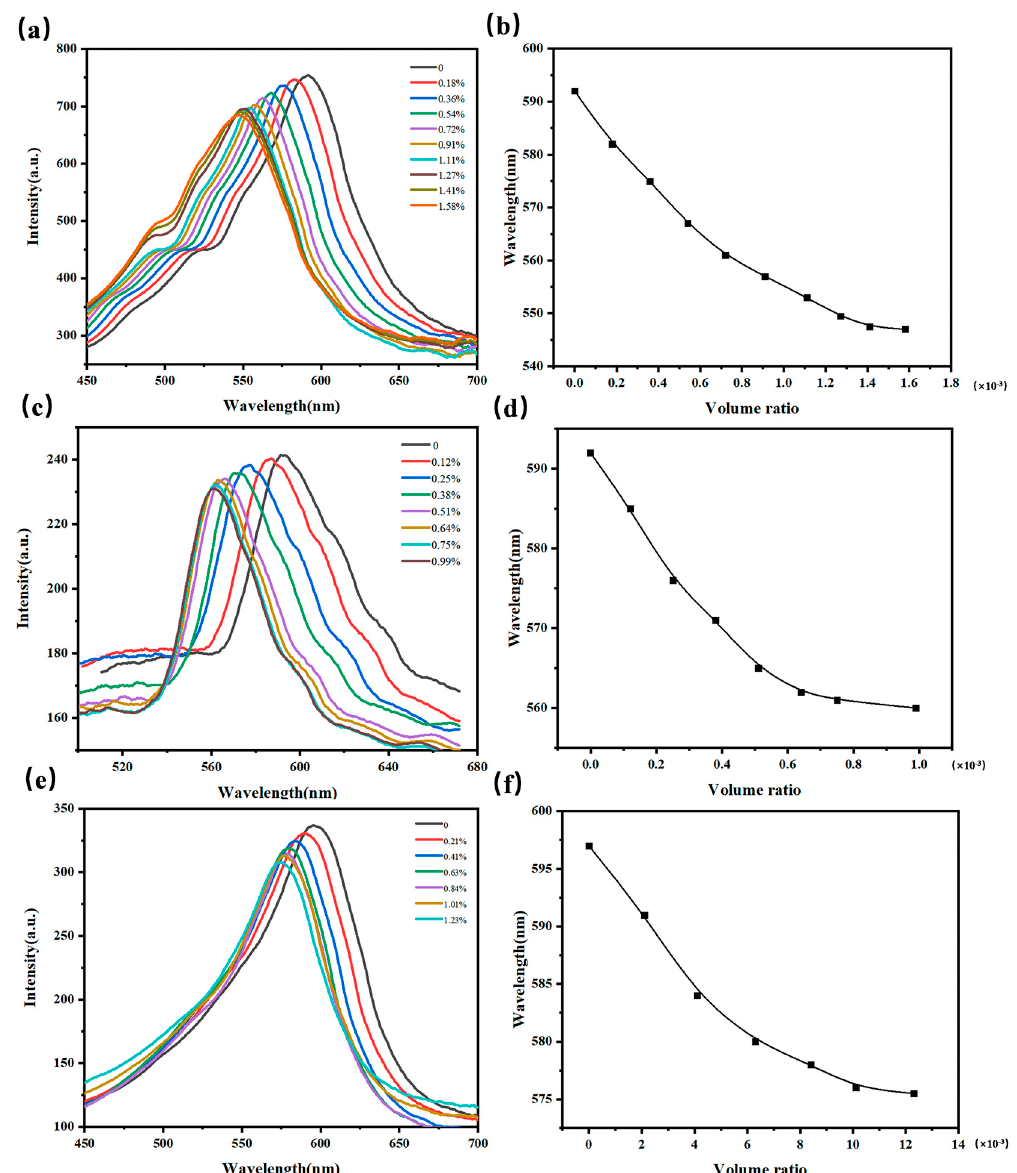
Figure 6. Responses of the 3D I − (A −β− CD) − AM PCs to VOC gas. ( a ) λ max responses of 3D I − (A −β− CD) − AM PCs to methanol gas; ( b ) the relationship between the wavelength of λ max and volume ratio; ( c , d ) λ max responses of 3D I − (A −β− CD) − AM PCs to ethanol gas; ( e , f ) λ max responses of 3D I − (A −β− CD) − AM PCs to propanol gas.